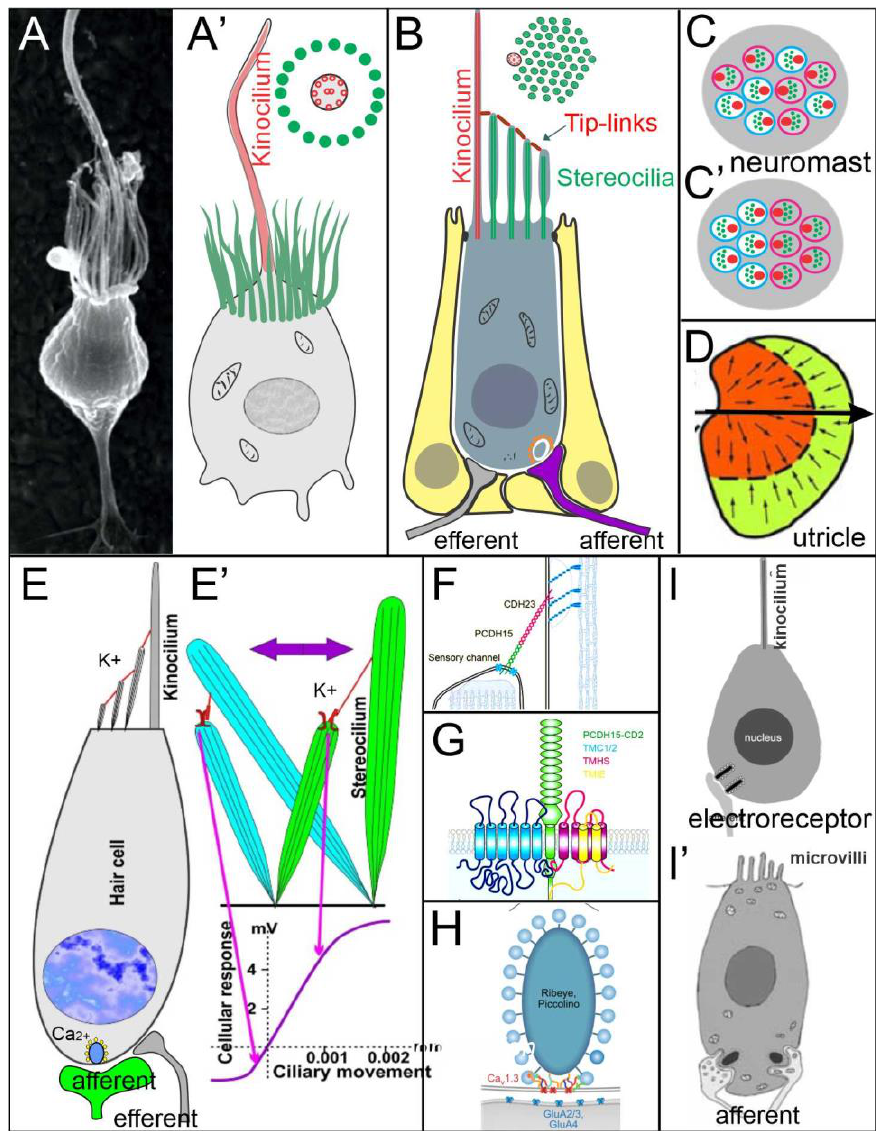
Figure 5. Mechanosensory hair cells evolve from single-cell organisms. Choanoflagellate ( A , A’ ) are the basis of animals that evolved from a kinocilium surrounded by microvilli into an asymmetric staircase of mechanosensory hair cells ( B , C , E ) that forms the mechanoelectrical transduction channels (MET) of the lateral line ( B , C , C’ ) and vestibular hair cells ( E ). The lateral line ( C , C’ ) and some vestibular hair cells ( D ) are bipolar, whereas canal cristae and most auditory organs are polarized in 1 direction. Tip links depend on CDH23 and PCDH15 ( F ) that interact with Tmc and others ( G ) to open up the channel ( E’ ) to allow K+ entrance. Ca2+ interactions with t ribbons to allow the release of glutamate ( E , H ). Electroreceptors are unpolarized and resemble Choanoflagellate that either show microvilli ( I’ ) or only a central kinocilium ( I ). Modified after [22,37,47,196,211,212]. The opposing polarity of hair cells and their selective innervation by afferent nerves is determined through the combined action of transcription factor Emx2 [40,41,213–215]. Ectopic expression of Emx2 drives all hair cells to organize their kinocilia in a caudal po- sition, while broadly activating the Notch pathway results in the inhibition of Emx2 ex- pression. Thus, all kinocilia are positioned rostrally [40,116,215]. It appears that a bistable situation then determines of Emx2 in the rostral sibling through Notch -mediated lateral inhibition, which then determines the caudal position for the kinocilium of the rostral sib- ling and the emergence of the opposing polarity [23].